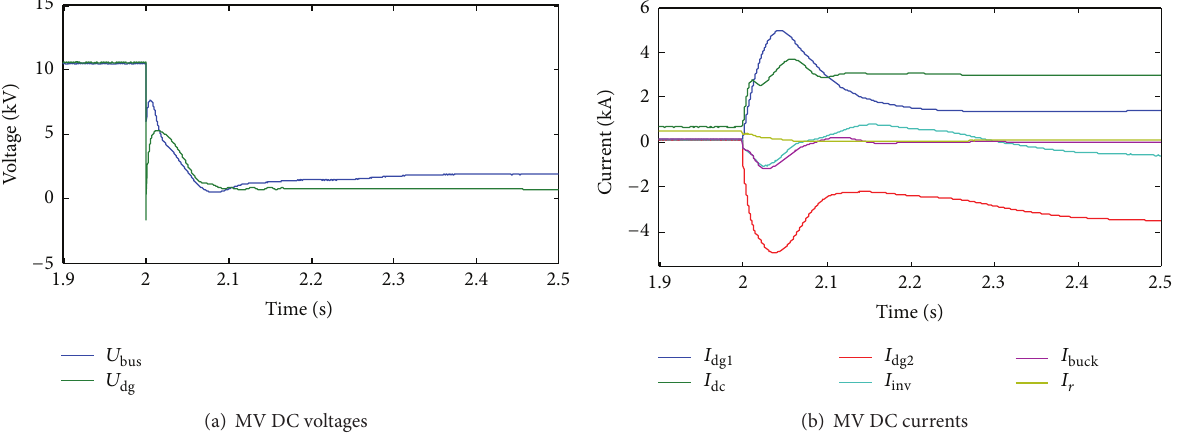
Figure 11: Transient response waveforms of fault F1.